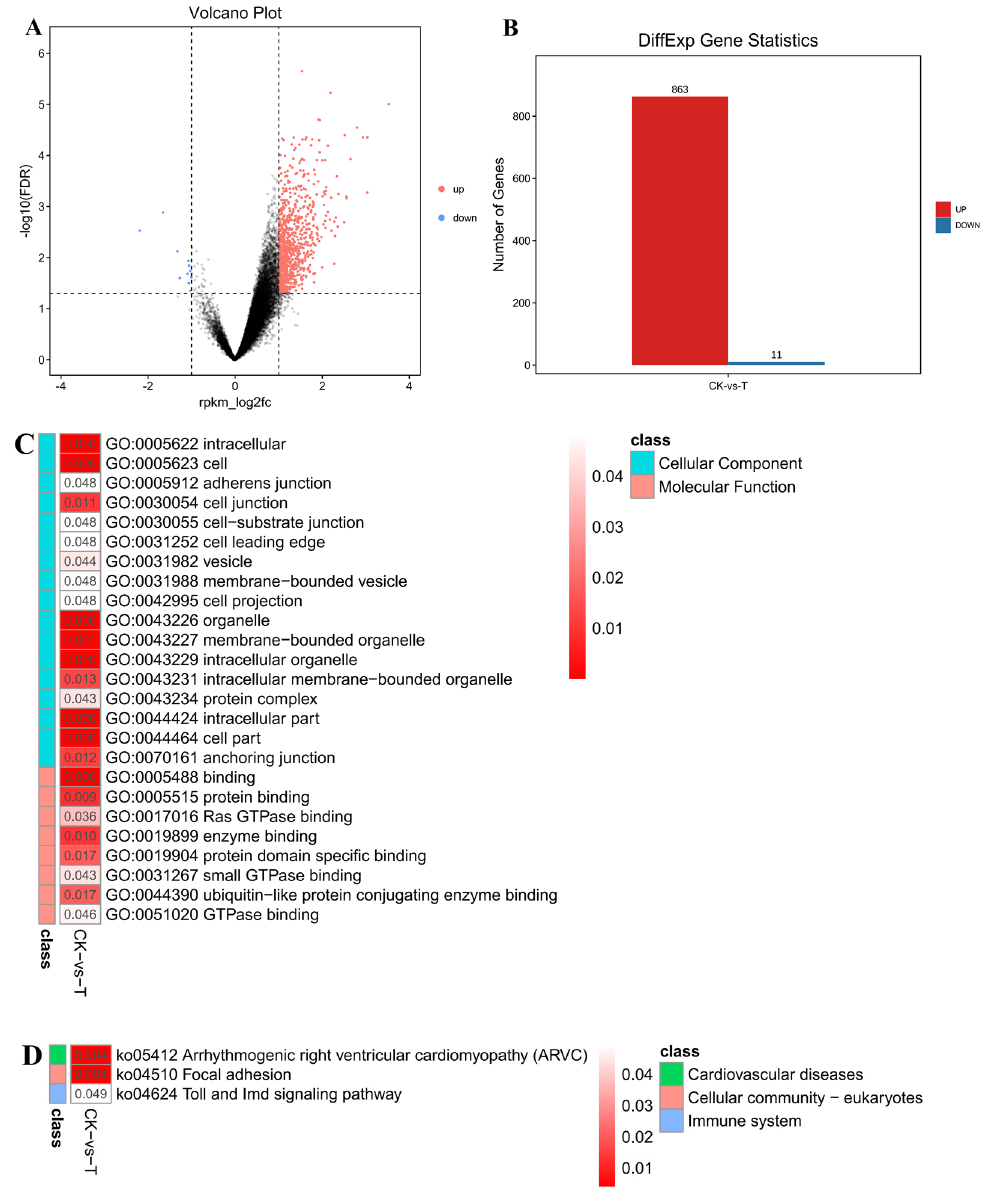
Figure 6. Enrichment analyses of the differential peaks and their corresponding genes. ( A ) Scatter plot of differential peaks (|log2(fold change)| ≥ 1, FDR ≤ 0.05). ( B ) Statistics for the differential peaks. ( C ) GO enrichment analysis of genes corresponding to different peaks between the two groups (Q < 0.05). ( D ) KEGG pathway enrichment analysis of genes corresponding to different peaks between the two groups (Q < 0.05).